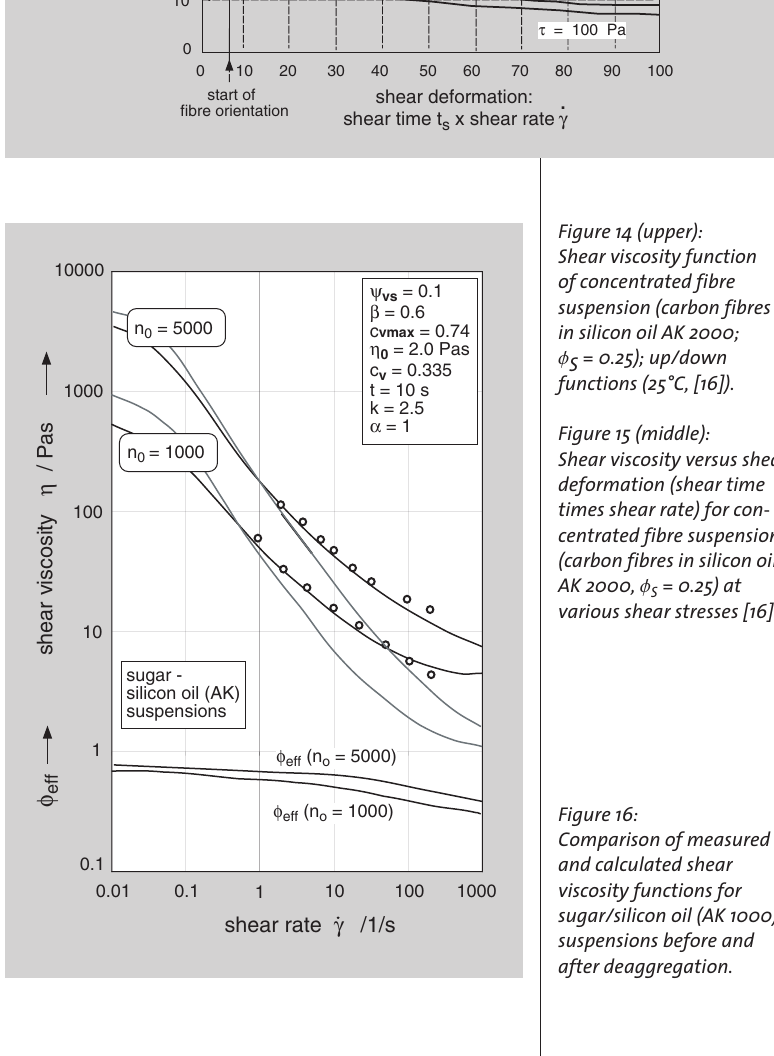
Figure 16: Comparison of measured and calculated shear viscosity functions for sugar/silicon oil (AK 1000) suspensions before and after